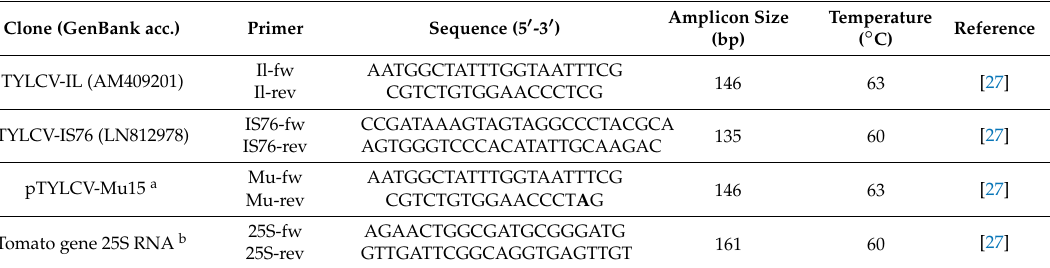
Table 4. Primers and real time PCR conditions used in the fitness